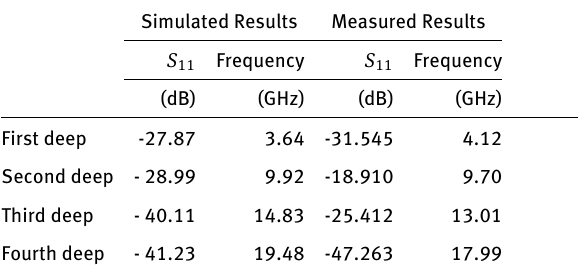
Table 4: Comparison of measured and simulated